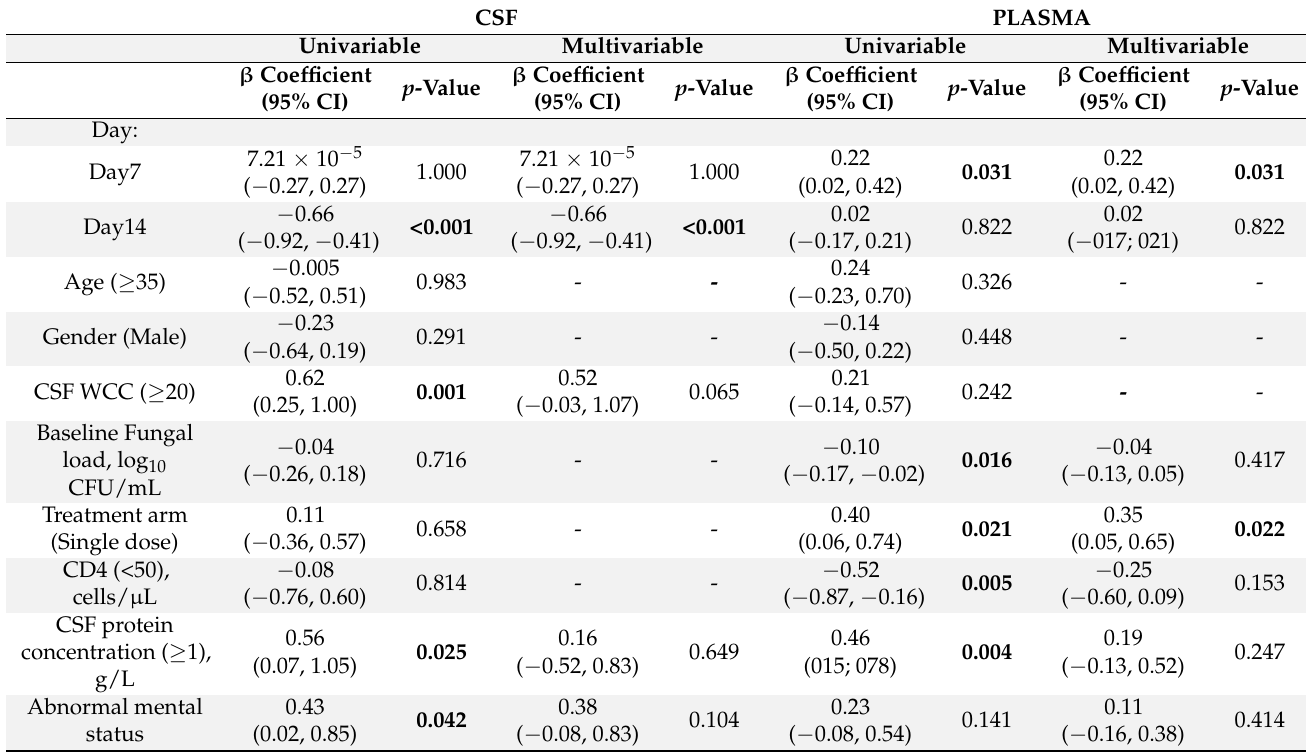
Table 4. Factors associated with changes in CSF and plasma HIV-1 over time in ART-naïve participants ( n =